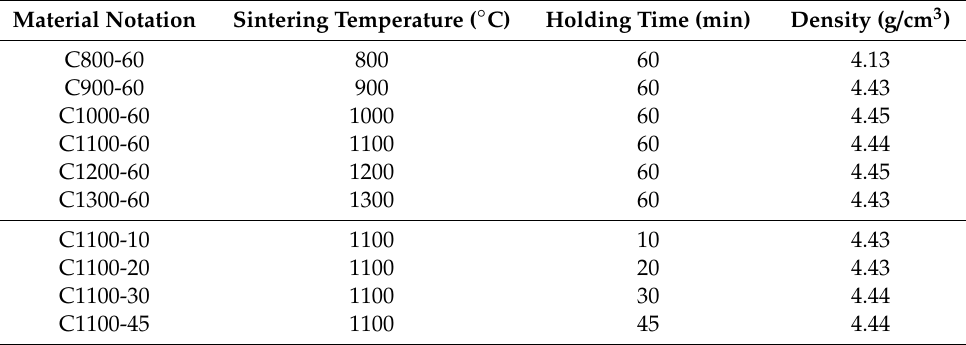
Table 2. The density of composites sintered at di ff erent